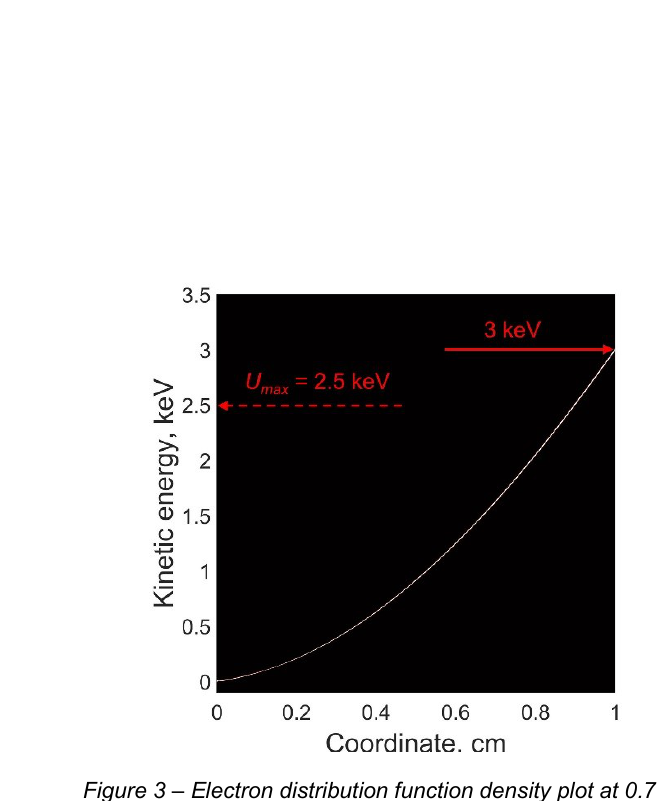
Figure 3 – Electron distribution function density plot at 0.7 ns